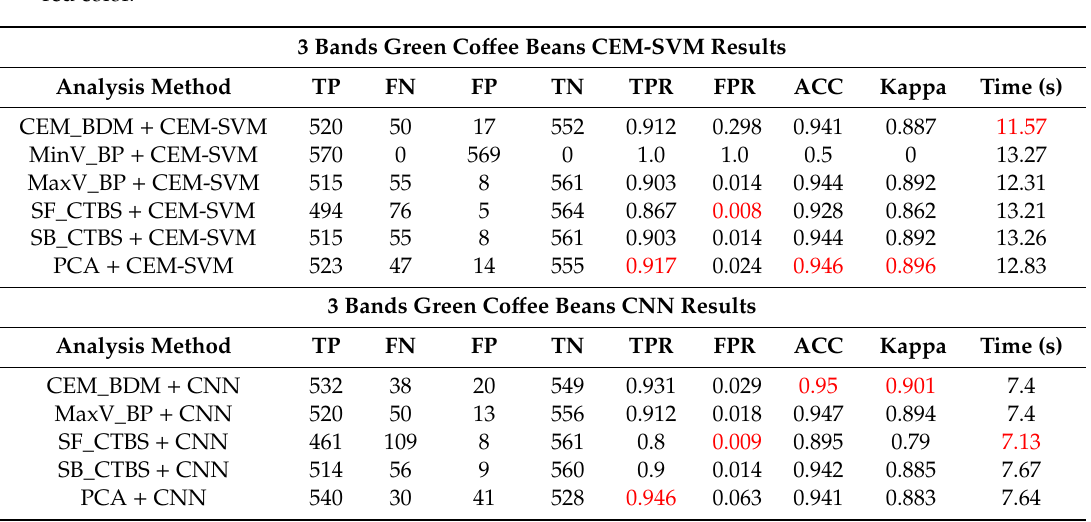
Figure 26. Results of green coffee beans CNN+ PCA three bands, ( a–d ) CNN classification results, ( e– h ) final visual images. Table 4. The results of the green coffee bean classification. The best performance is highlighted in red color.